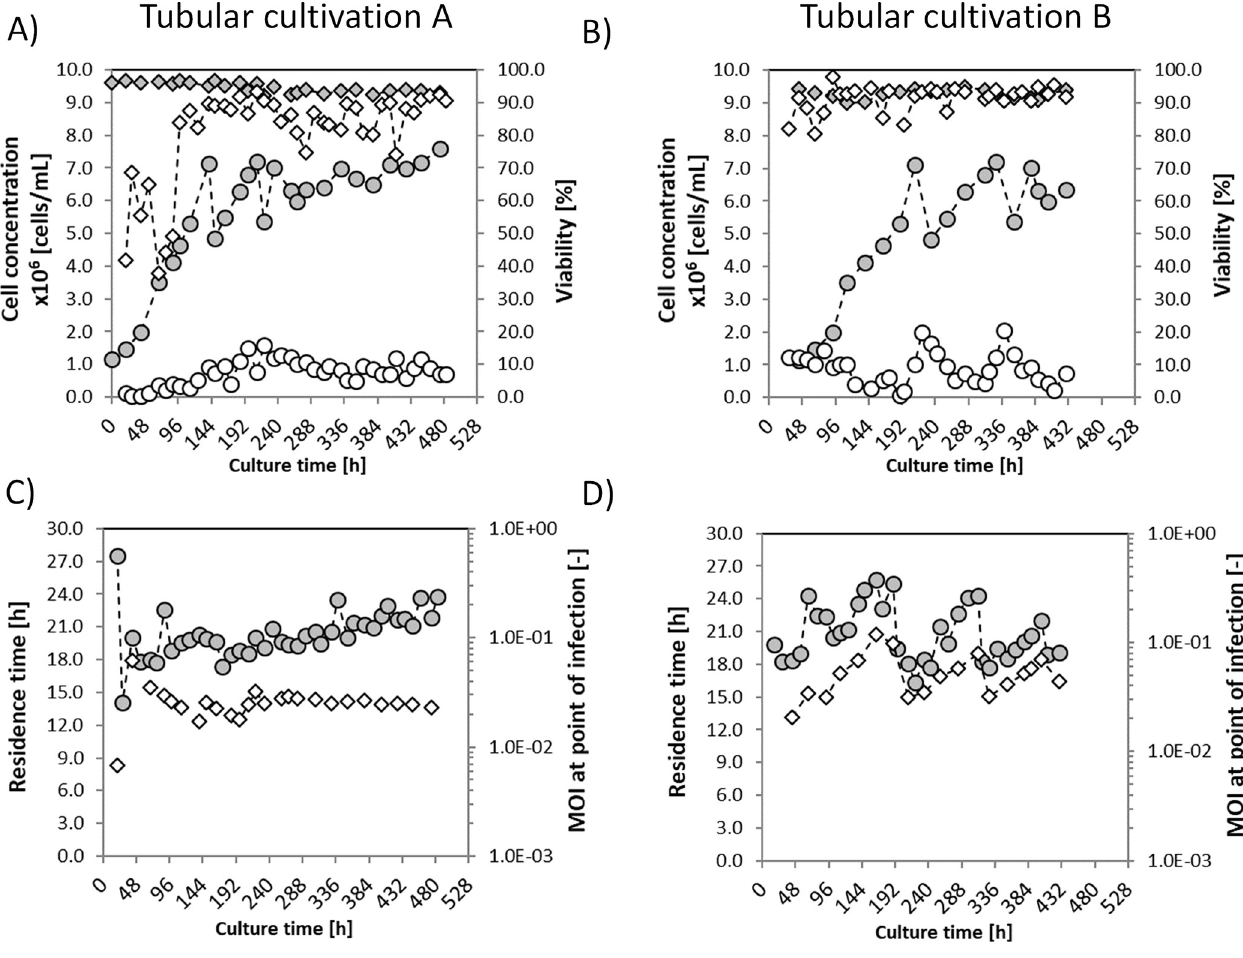
Fig 5. Cell concentration, viability, residence time and MOI of tubular cultivation A and B for production of influenza A virus in AGE1.CR.pIX. A) and B), viable cell concentration (circles) and viability (diamonds) of the CSTRs (grey symbols) and the PFBR harvests (open symbols). C) and D) Residence time (circles) of the PFBRs and actual MOI at the POI